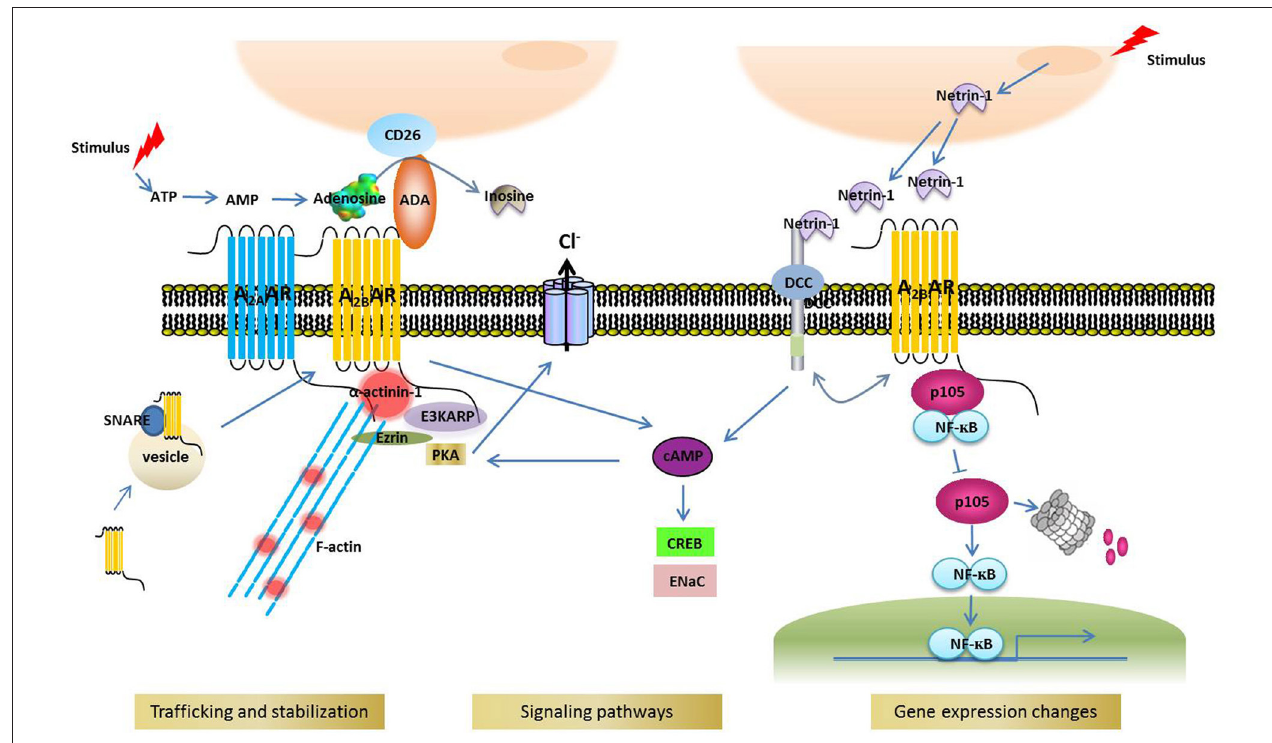
FIGURE 1 | A 2B AR binding partners and their cellular